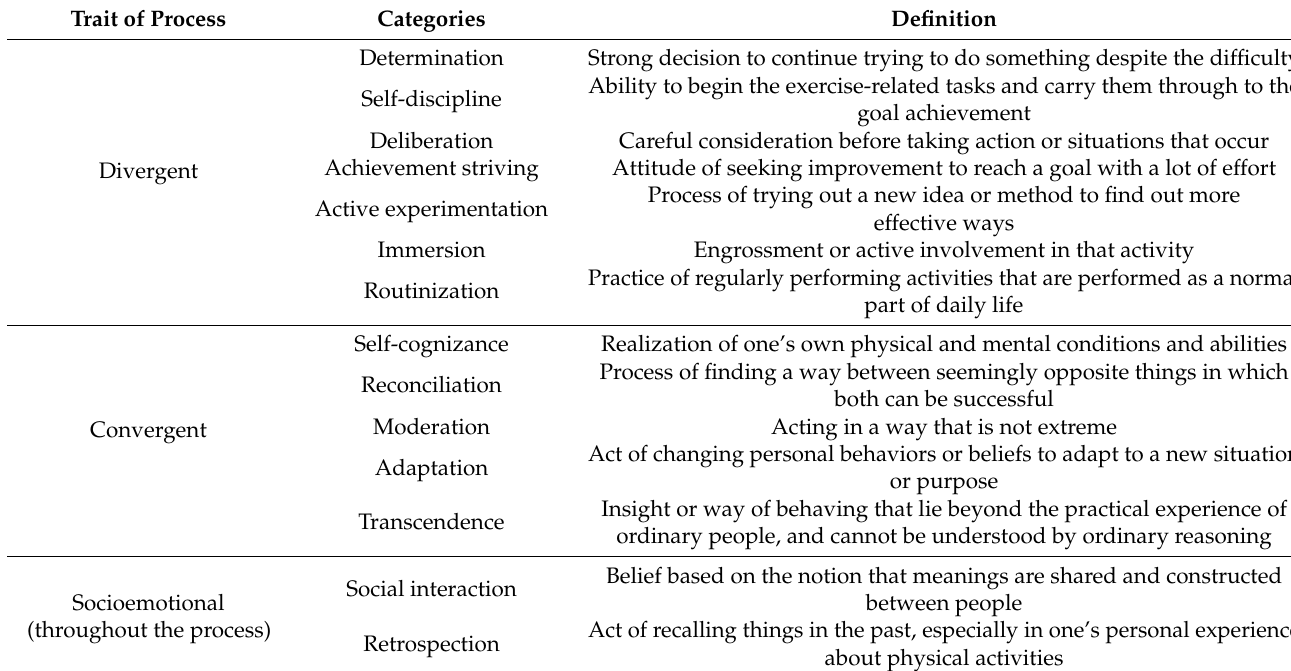
Table 4. Three traits of the process in action/interactional